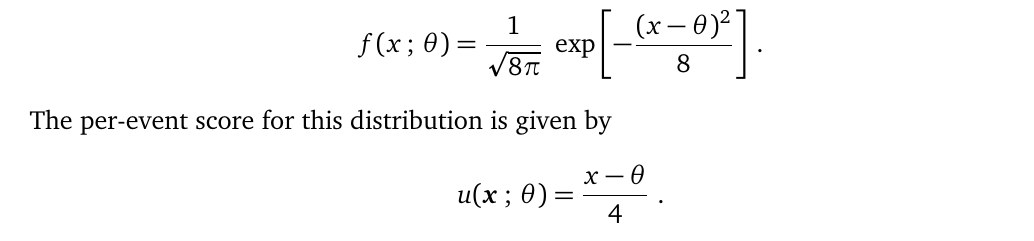
Figure 1: The red lines show distributions f ( x ) given by (38) for θ = θ ± 0.3 (dotted lines). The green dot-dashed line shows the distribu- line) and θ = θ 0 tion f ( x ) | u ( x ) | for θ = θ . All distributions have been unit-normalized in the range 0 0 ≤ x ≤